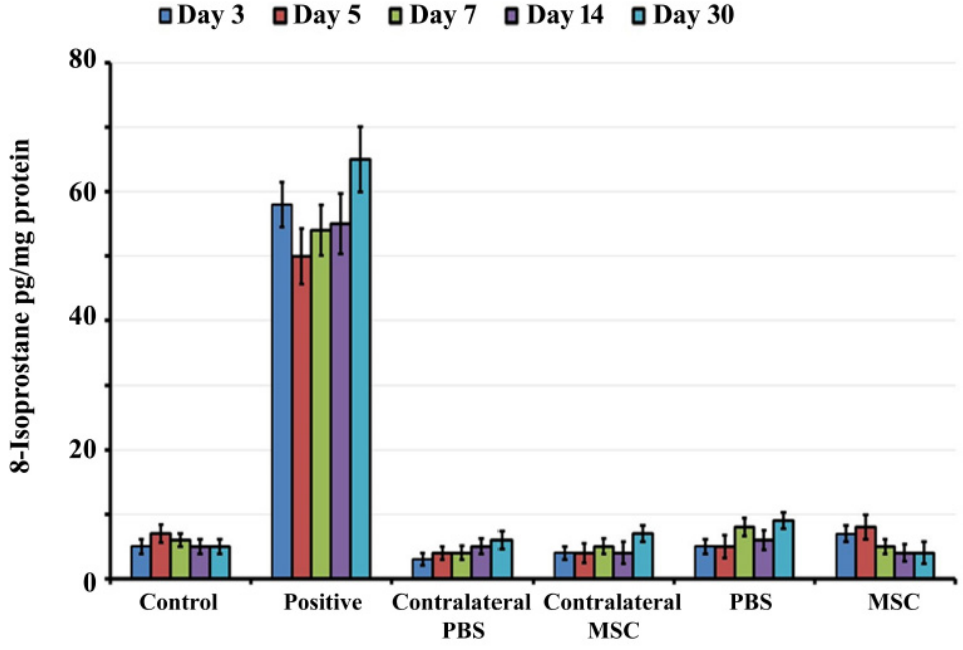
Figure 1. Oxidative stress determination: The levels of 8-isoprostane as a marker of oxidative stress was determined in whole cochlear tissue homogenates by ELISA at 3, 5, 7, 14, and 30 days post-administration. There was no statistically significant di ff erence in 8-isoprostane levels in cochleae harvested from rats that received bone marrow mesenchymal stem cells (BM-MSCs), phosphate bu ff ered saline (PBS) injected, or control group.